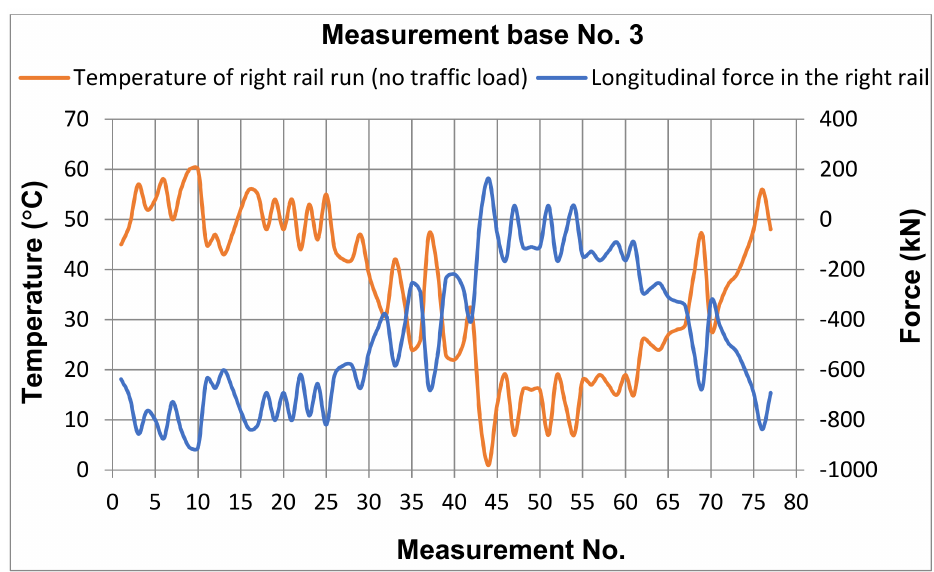
Figure 13. Results of measurements of temperature and longitudinal force of right rail without load of a passing train—measurement base No. 3 (source: own